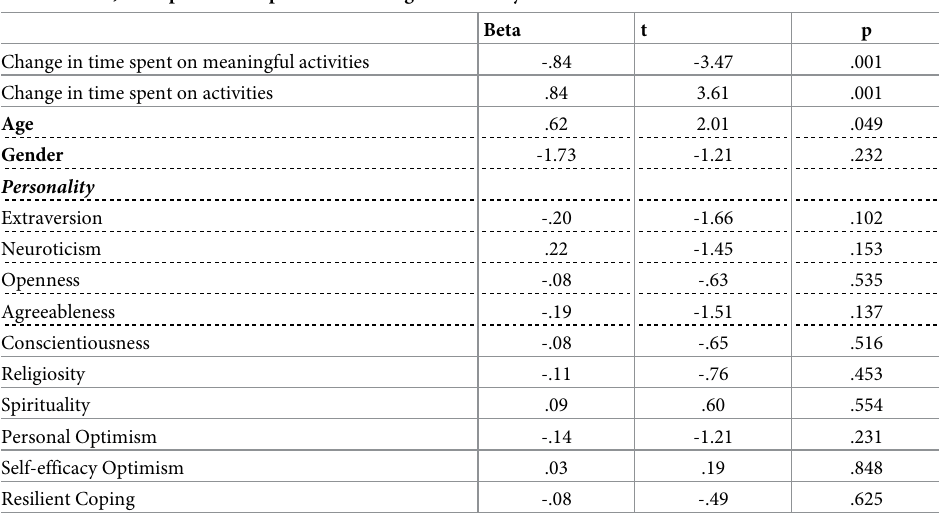
Table 3. Beta, t and p values for predictors for regression analysis 2.